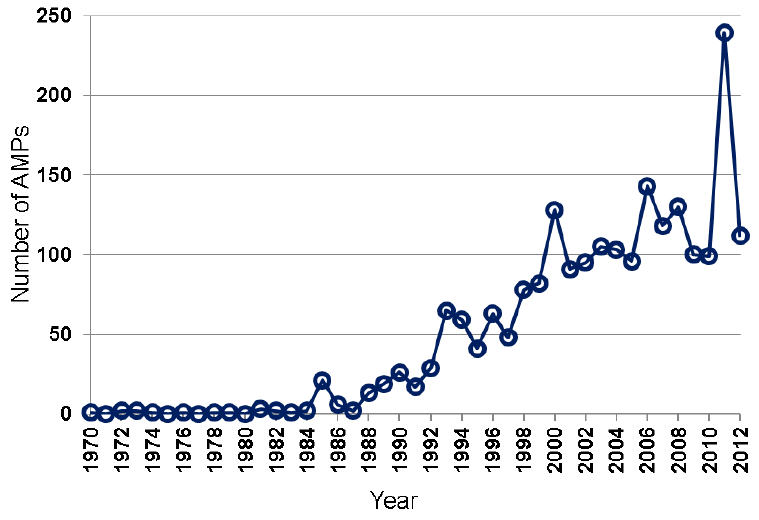
Figure 2. Antimicrobial peptides discovered each year from 1970 to 2012. Data were obtained from the antimicrobial peptide database ( http://aps.unmc.edu/AP )